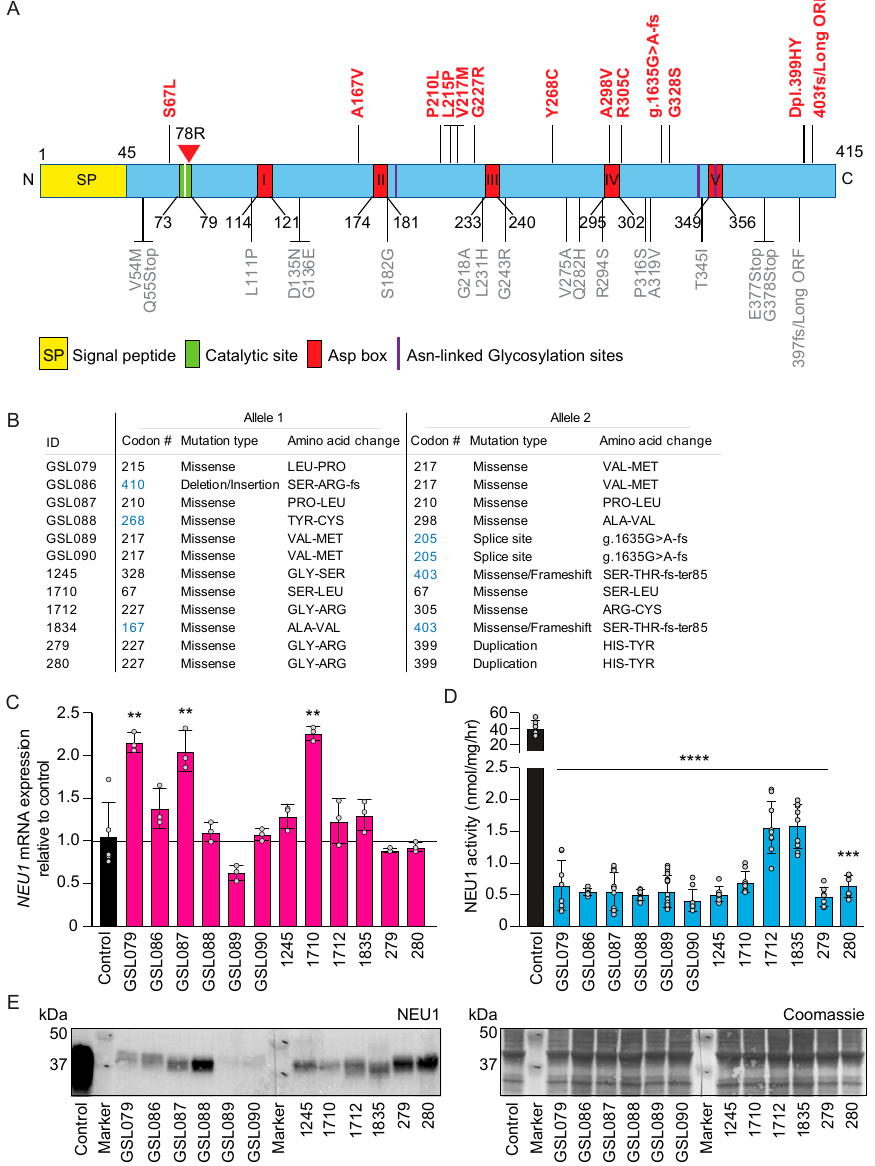
Figure 1. Molecular and Biochemical Characteristics of Sialidosis Patients ( A ) Schematic representation of neuraminidase 1 (NEU1) mutations within the primary structure of NEU1. Mutations indicated in red are those belonging to the sialidosis type I patients used in this study. Conserved Asp-box motifs are numbered I–V, and amino acid positions are indicated. The signal peptide (SP) is marked by a yellow box. ( B ) Biallelic NEU1 mutations in the cohort of sialidosis type I patients used in these studies. Mutations in blue were not previously described. ( C ) Levels of NEU1 mRNA in sialidosis fibroblasts were calculated relative to those in control cells ( n = 3). ( D ) NEU1 residual activity assayed in sialidosis type I fibroblasts ( n ≥ 6). ( E ) Western blot analysis of NEU1 mutant proteins in lysates of sialidosis type I cells; short and long exposure of a representative immunoblot probed with anti-human NEU1 antibody. Coomassie stained immunoblot used as loading control ( n = 3). Graphs are presented as mean ± SD. Statistical analysis was performed using Student t -test. ** p < 0.01, *** p < 0.001, **** p < 0.0001.